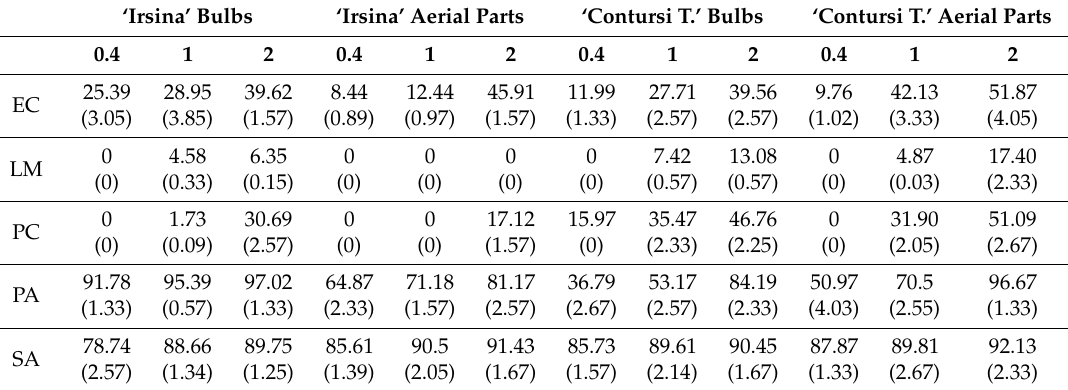
Table 4. Inhibition of the metabolic activity exhibited by the bacterial cells in the presence of di ff erent concentrations of the extracts of bulbs and aerial parts of ‘Irsina’ and Contursi T.’ landraces. The data are expressed as percentage respect to the control (assumed as 0%). Results are the mean of three experiments ( ± SD). EC: E. coli ; LM: L. monocytogenes ; PC: P. carotovorum ; PA: P. aeruginosa ; SA: S. aureus